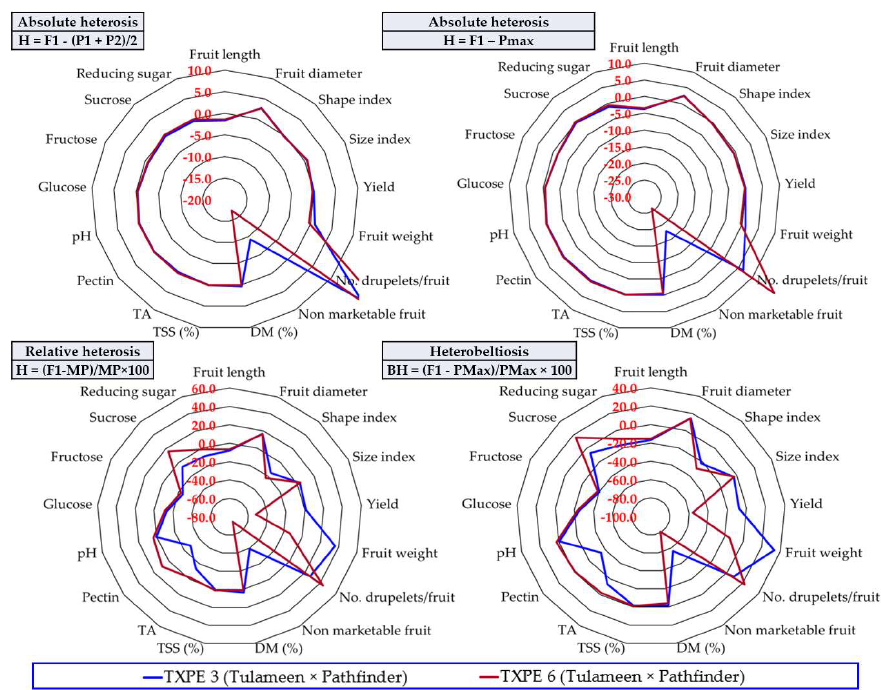
Figure 9. The heterosis effect upon the 17 analyzed characteristics in two promising selections obtained from the hybridization of Tulameen × Pathfinder.